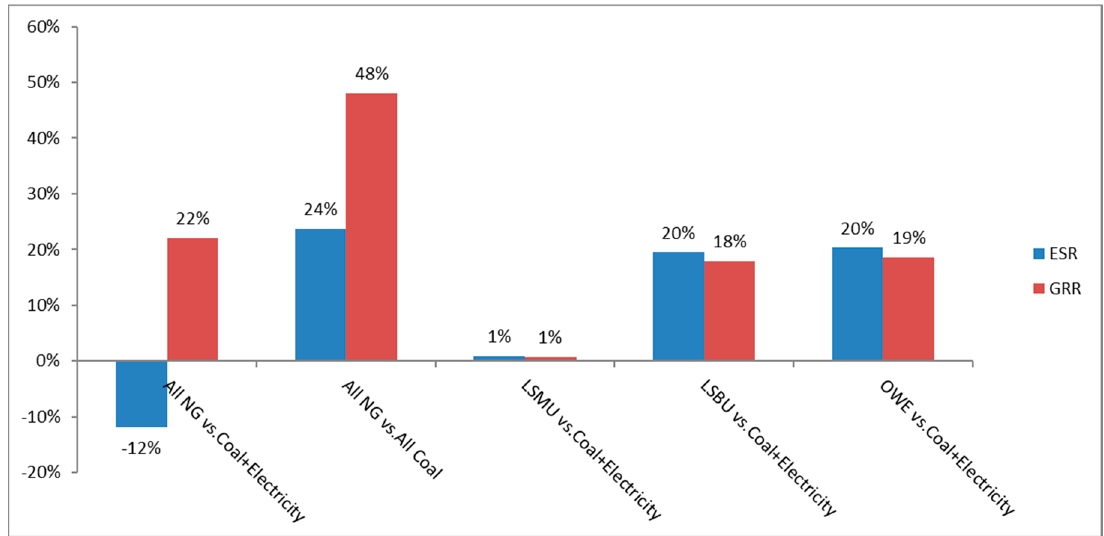
Figure 4. Life cycle energy saving and GHG emissions reduction under different